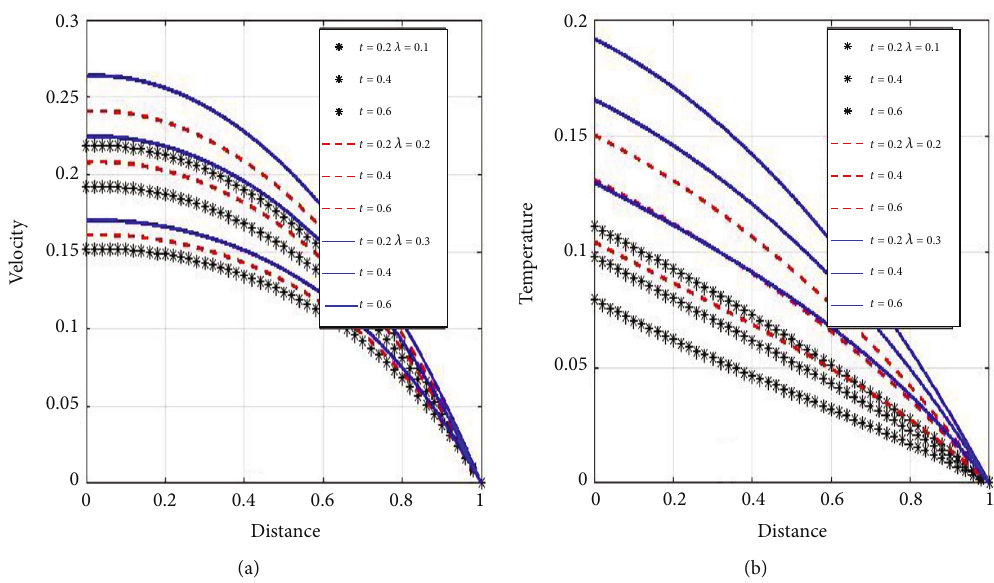
Figure 6: Unsteady-state λ for velocity and temperature.